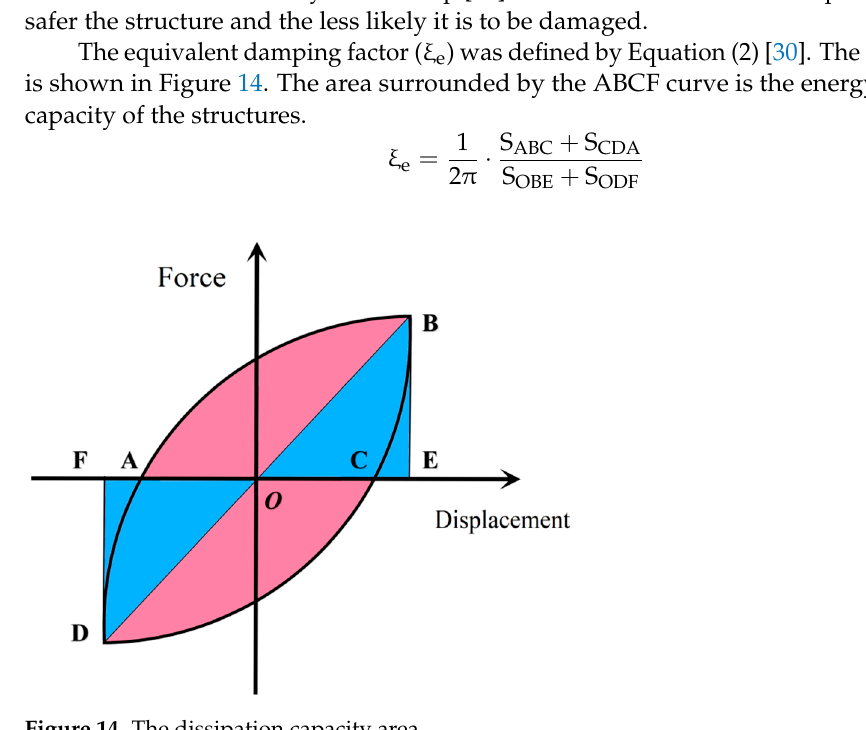
Figure 14. The dissipation capacity area.